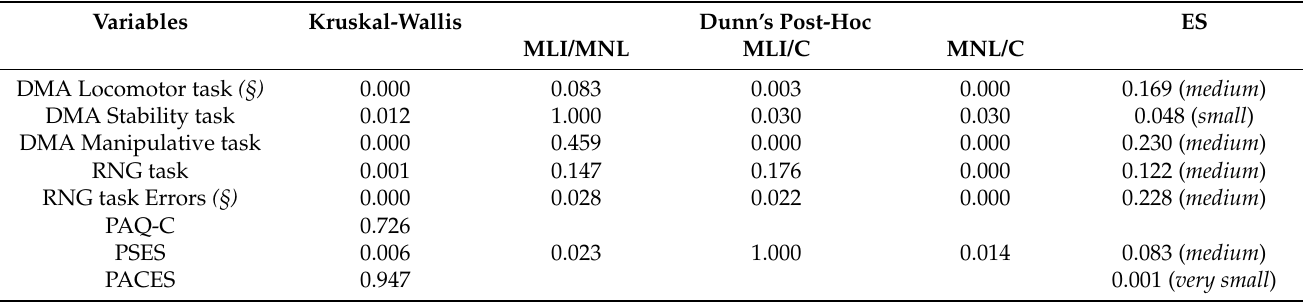
Table 2. Between-group comparisons of teaching approach on critical thinking, executive functioning, physical activity, self-efficacy, and enjoyment.